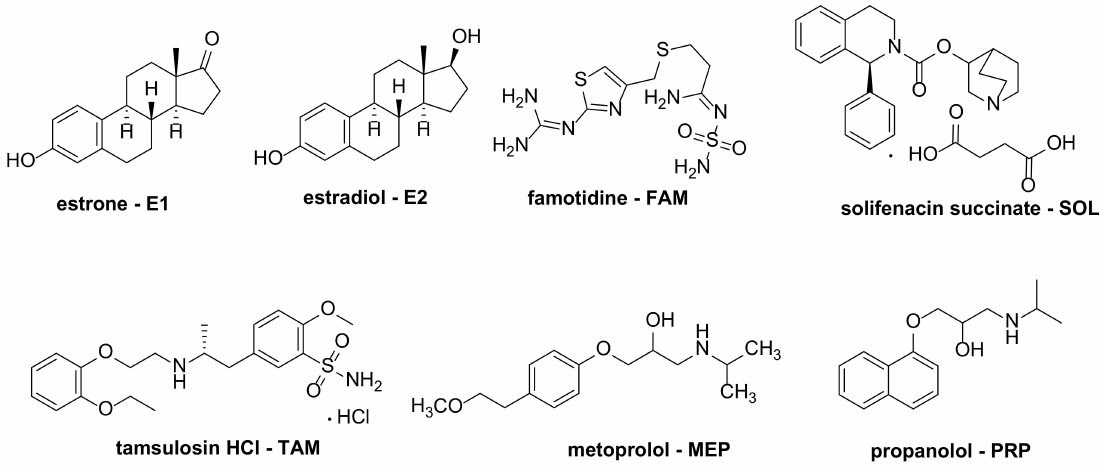
Figure 13. Structures of miscellaneous pharmaceuticals.